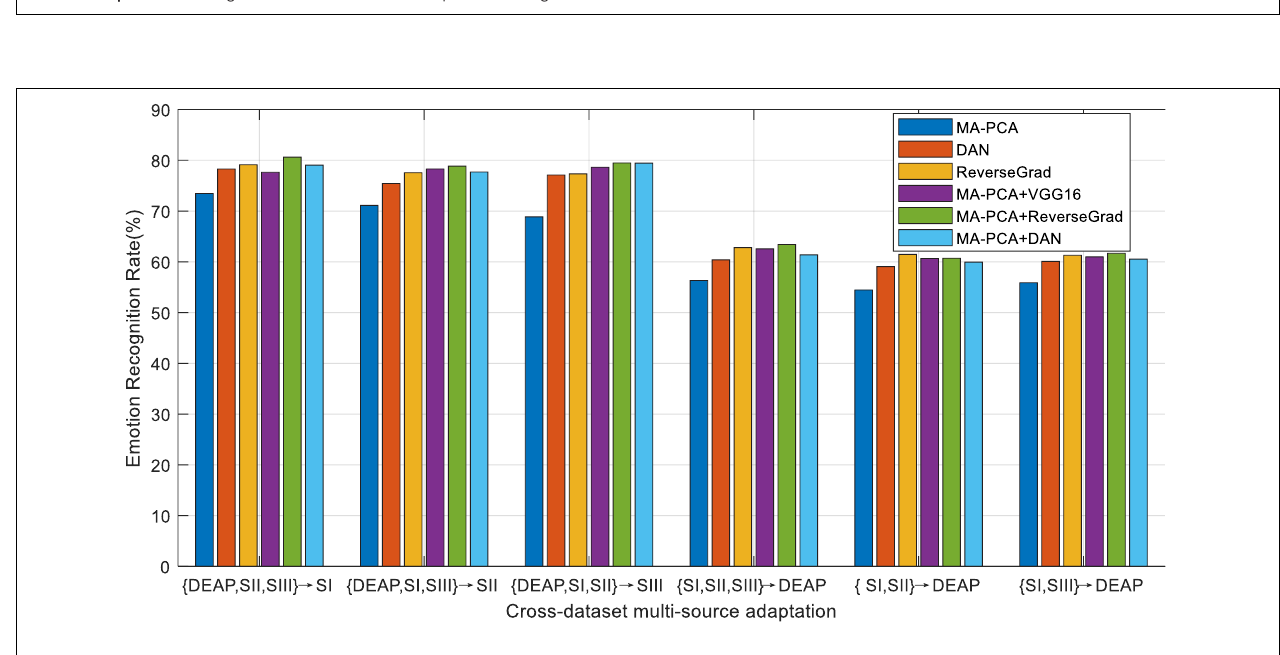
FIGURE 4 | Emotion recognition with multi-source adaptation settings.